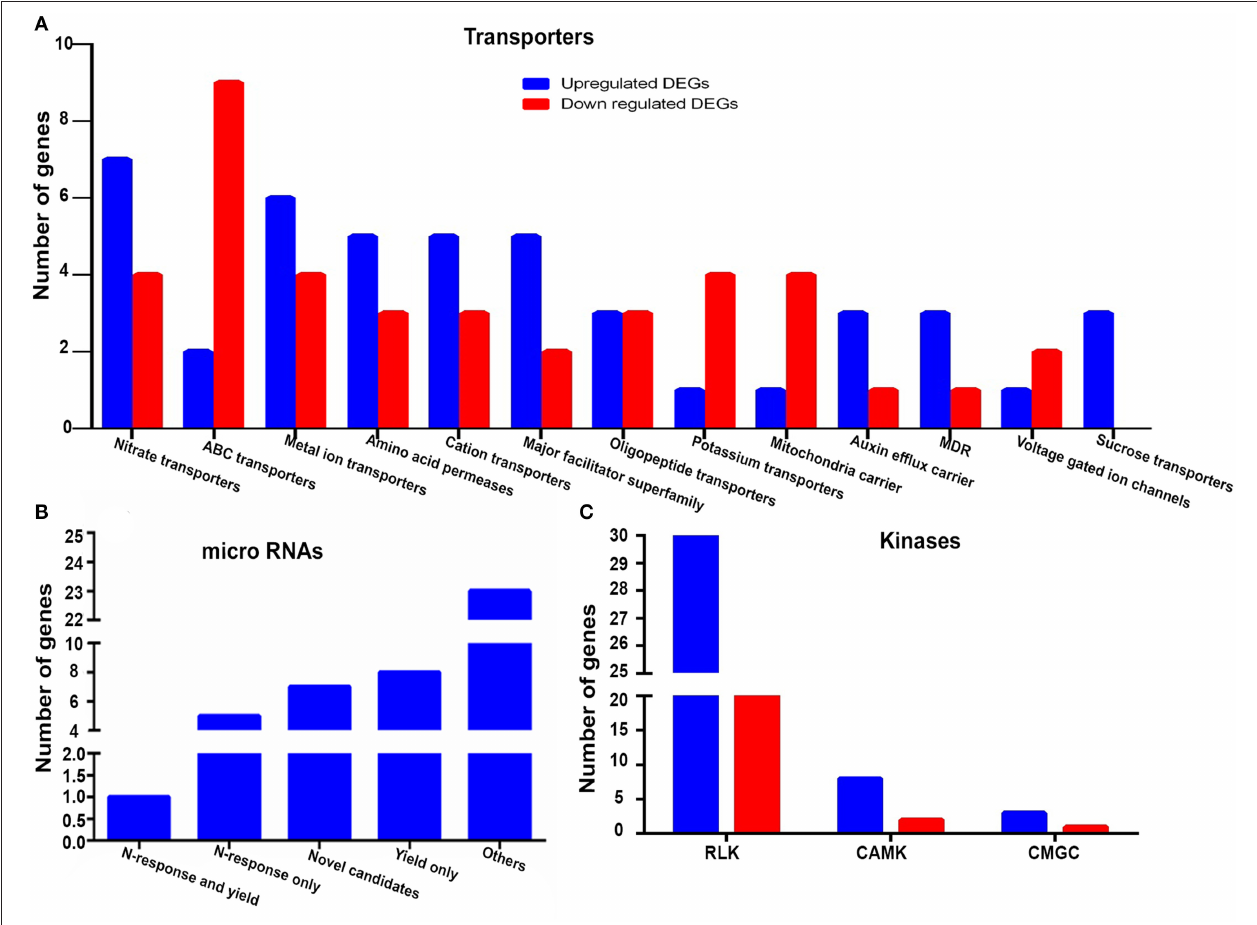
FIGURE 5 | (A) Family-wise classification and distribution and upregulated and downregulated NUE-related transporters (B) microRNAs (miRNA) belonging to N-response, yield, N-response and yield, other categories and reporting for the first time (novel NUE-genes) (C) Upregulated and downregulated major families of NUE-related